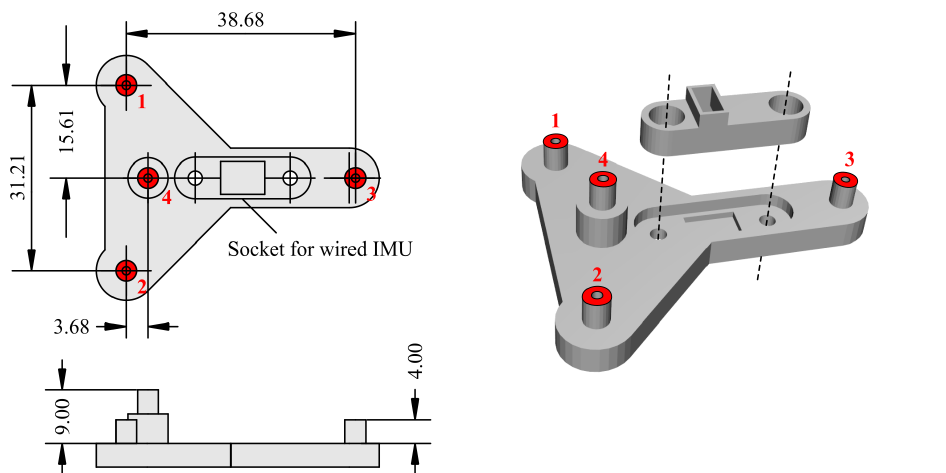
Figure A2. Dimensions (in mm) of the headborne 3D-printed support used for concurrent IMU and optical motion capture measurements (see also Figure 2a). The wired IMU was secured in a dedicated socket using an additional piece (right) and a pair of nylon screws and nuts. Red areas represent the location of infrared reflective markers. Numbers assigned to the markers are indicated in red.